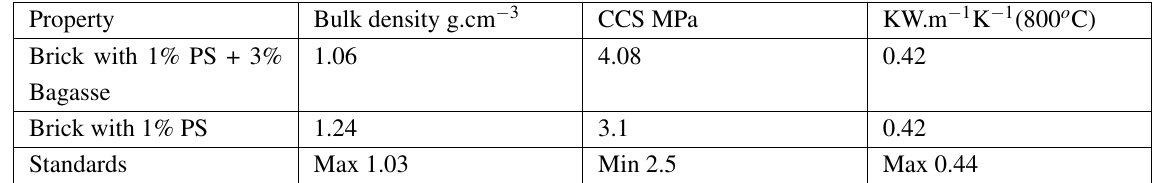
Table 9. Properties of chosen composition of insulating refractory